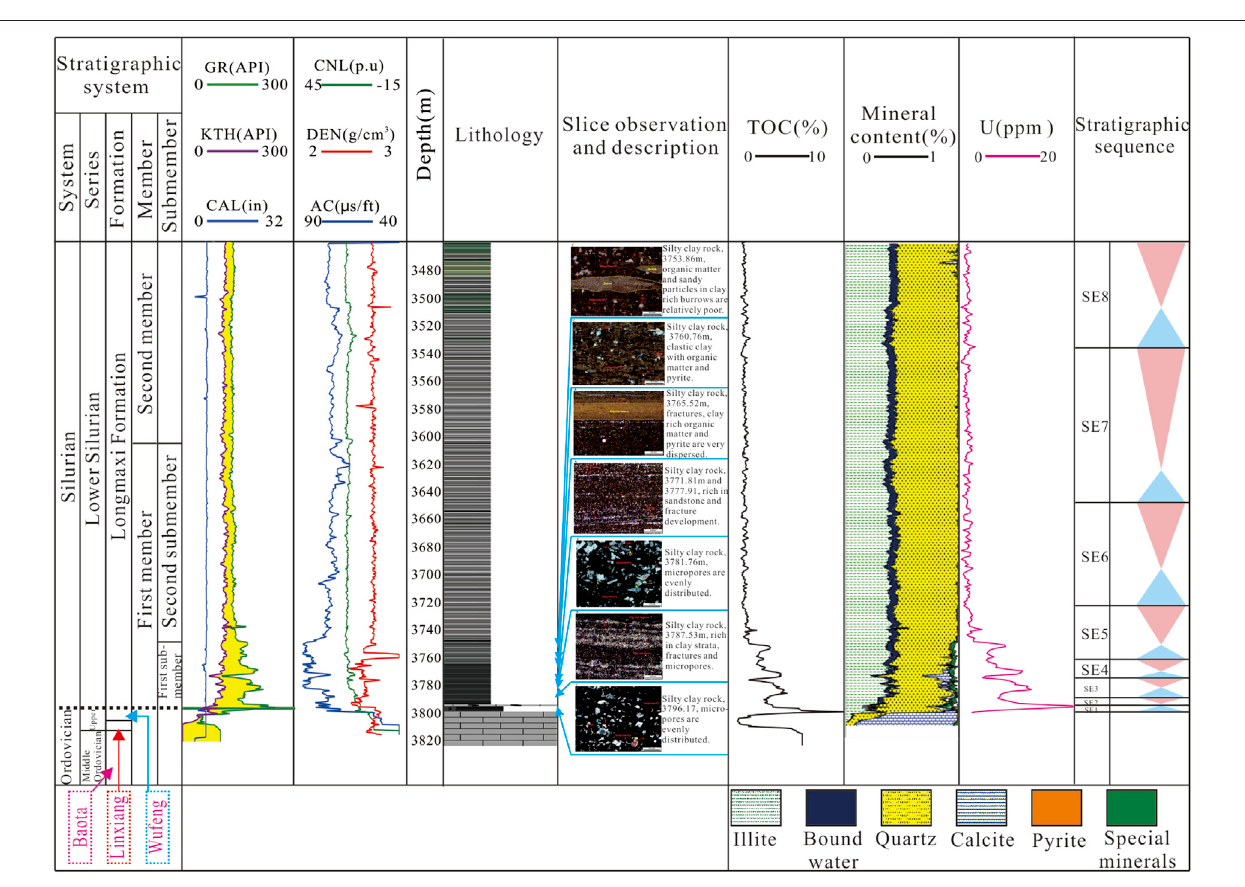
Frontiers in Earth Science |